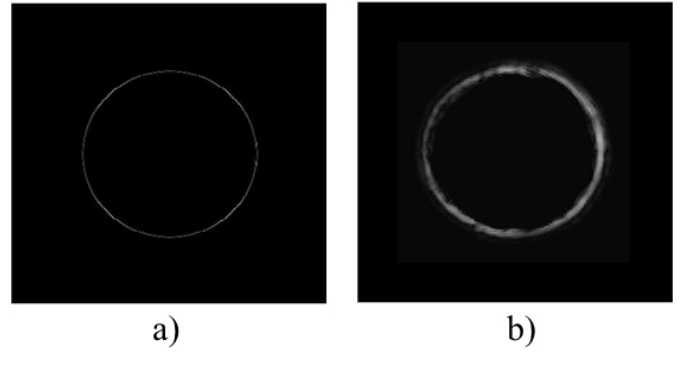
Figure 6. Far-field diffraction patterns of diffractive axicon. ( a ) Simulated diffraction pattern; ( b ) experimental diffraction pattern recorded by CCD camera.